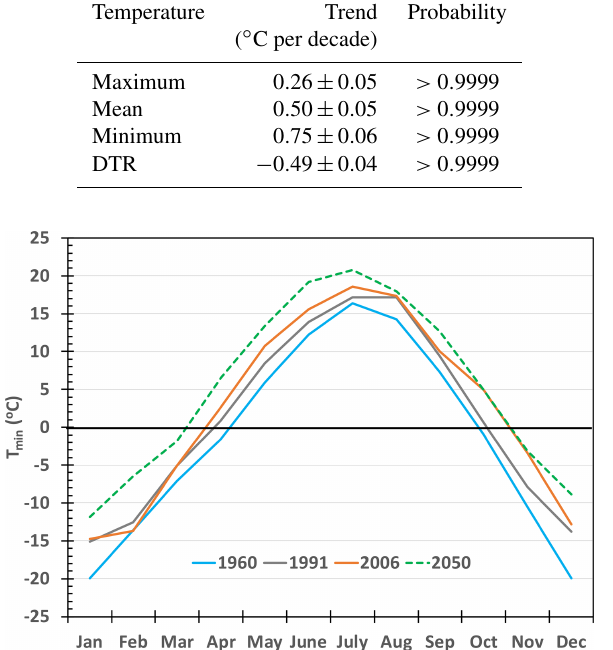
Figure 4. Change in the distribution of area-averaged monthly min- imum temperatures in Hetao. Values for 1960, 1991 and 2006 are actual measured distributions from years with similar annual pre- cipitation and that for 2050 is projected from monthly trends.